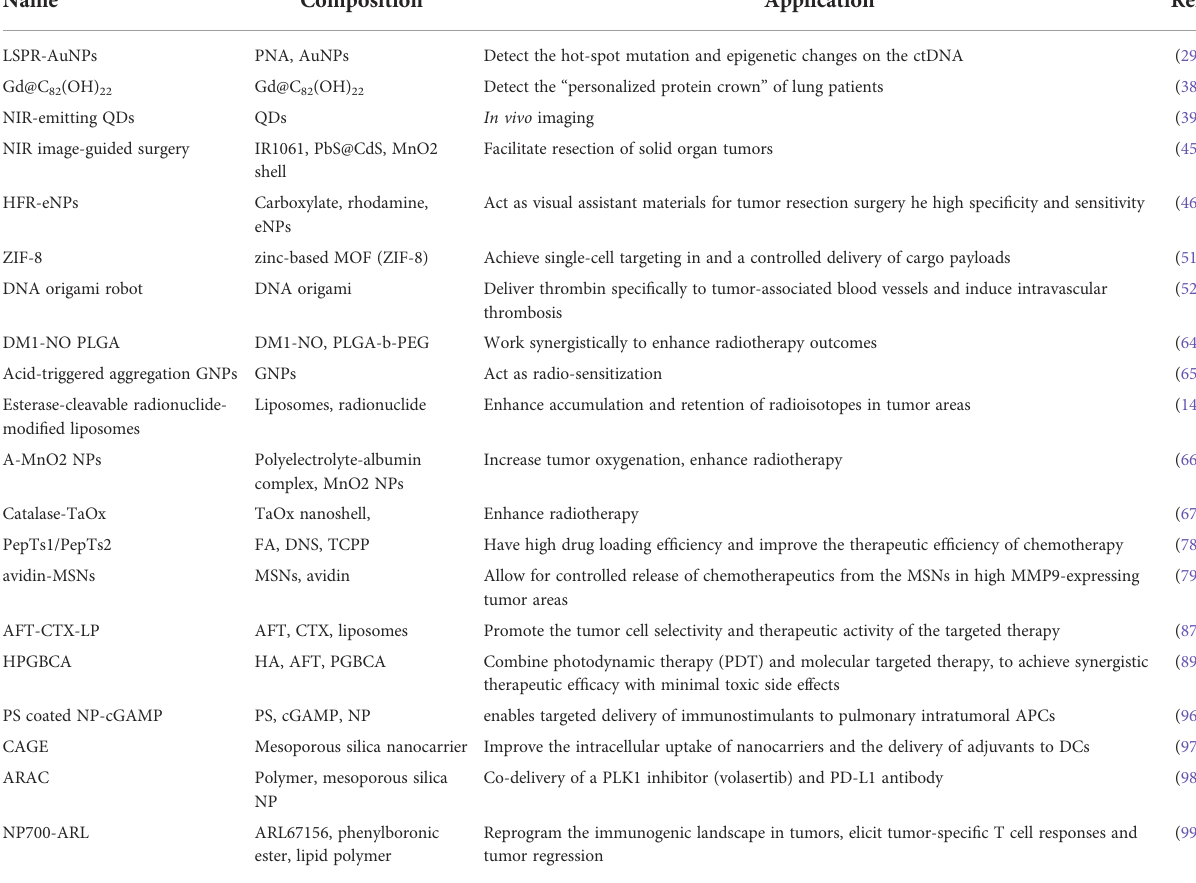
TABLE 1 Overview of nanotechnology for the diagnosis and treatment of lung